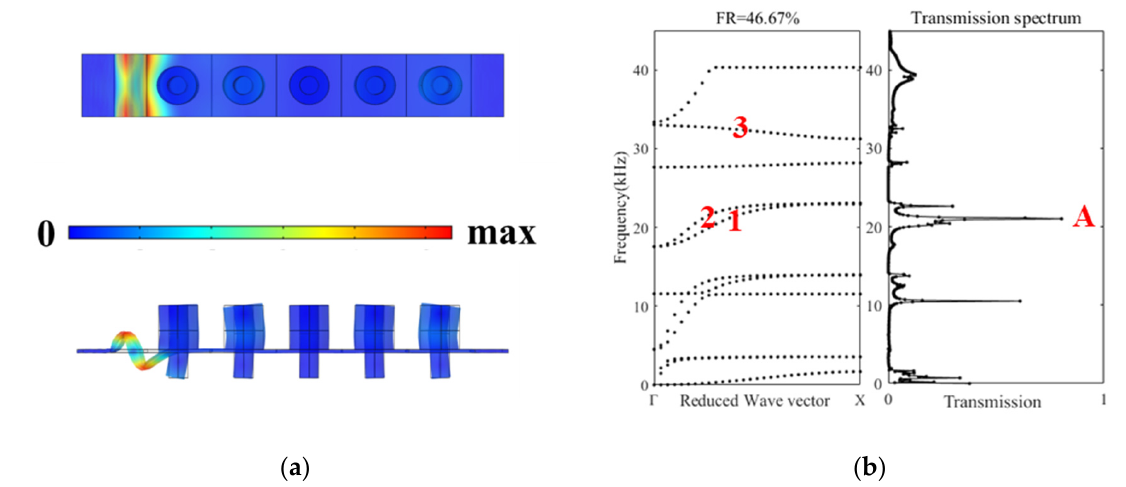
Figure 5. The transmission spectrum under the array element. ( a ) Distribution of structural displacement field. The top view is the upper half and the front view is the lower half; ( b ) dispersion curve (left) and transmission spectrum (right) of anti-symmetric Lamb wave passing through hollow pillar PCs with FR = 46.67%.